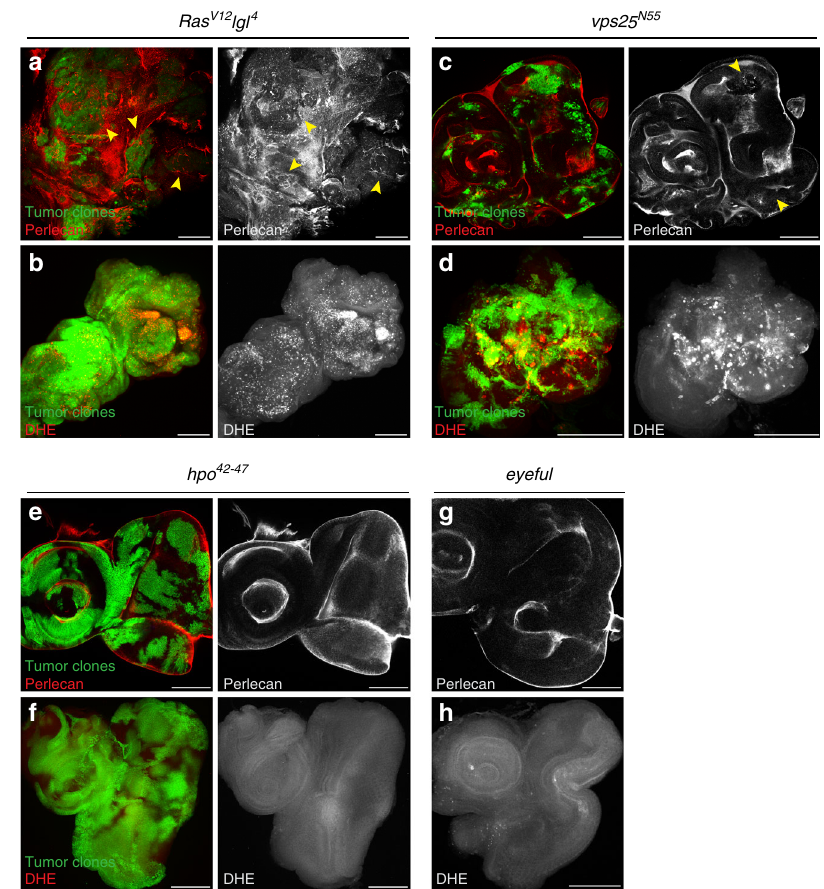
Fig. 2 BM damage coincides with ROS production in neoplastic tumor models. Except for eyeful ( g , h ), tumor clones were generated by the MARCM technique using ey-FLP and are marked by GFP. eyeful is uniformly expressed in the ey-Gal4 domain. Scale bars, 100 μ m. a , c , e , g The BM is detected by anti-Perlecan labeling (red left; gray right and g ). Panels are single slices focusing on the basal side of DP. Quanti fi cation in Supplementary Fig. 6a. b , d , f , h ROS is detected by the dihydroethidium (DHE) indicator dye (red left; gray right and h ). Panels are maximum intensity projections. Quanti fi cations in Supplementary Fig. 6b. Exact genotypes: a , b yw ey-FLP / + ; lgl 4 FRT40A / tub-Gal80 FRT40A ; act > y + >Gal4, UAS-GFP56ST / + . c , d yw ey-FLP / + ; FRT42D vps25 N55 / FRT42D tub-Gal80 ; act > y + >Gal4 UAS-GFP56ST/ + . e , f yw ey-FLP / + ; FRT42D hpo 42 – 47 / FRT42D tub-Gal80 ; act > y + >Gal4 UAS-GFP56ST/ +